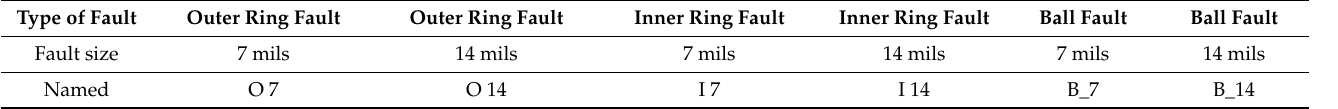
Table 1. The six fault categories are named B7, I7, O7, B14, I14, and O14, and the data for each fault type contained 120,000 data points. Table 1. Test conditions and descriptions.